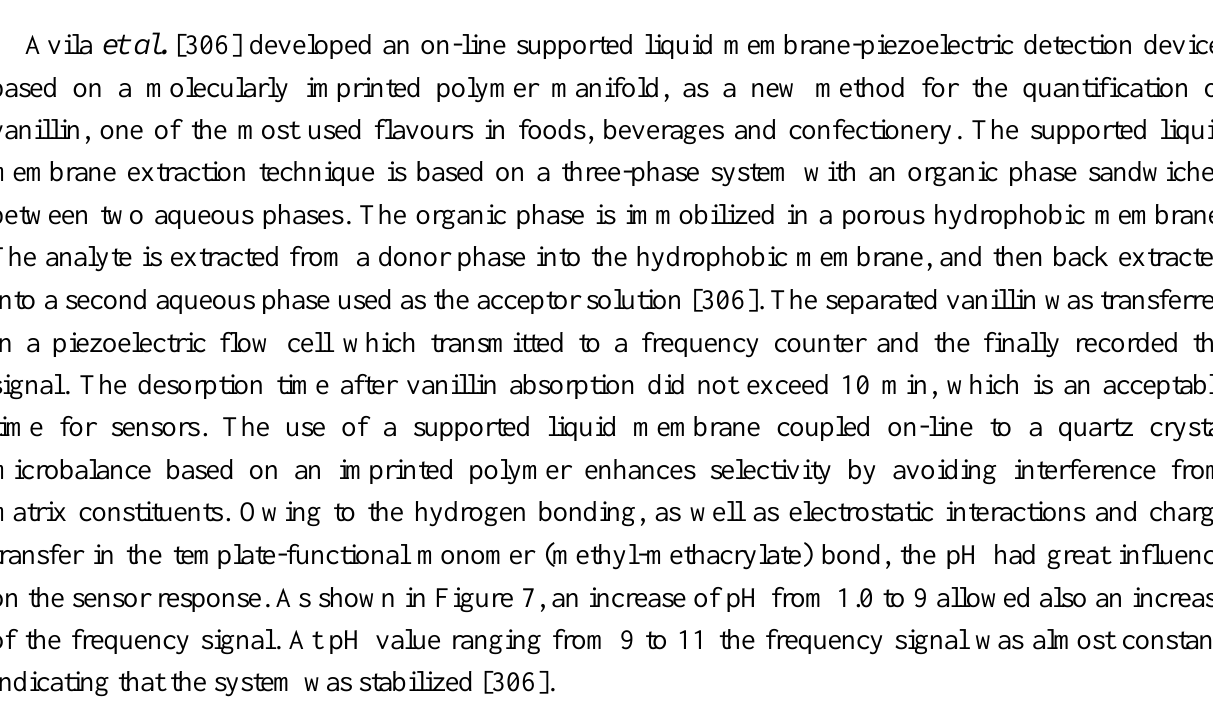
Figure 7. Influence of pH on the sensor response during determination of vanillin in food samples (Data from